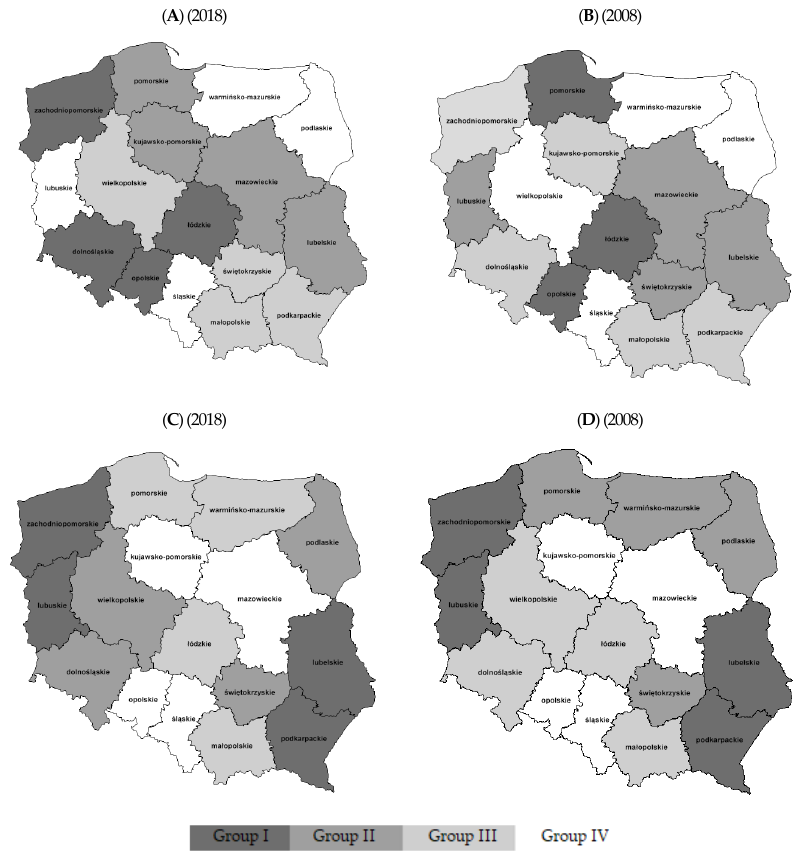
Figure 3. Quartile groups for measures of synthetic agricultural potential of Polish voivodships in 2009 and 2018 according to the value of local statistics of I Moran. ( A , B ) (agriculture) ( C , D ) (development). Source: own study based on the BDL CSO data